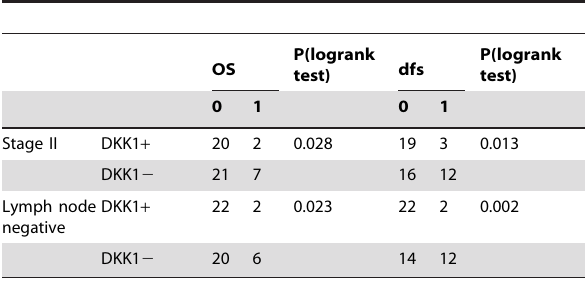
Table 5. Prognostic value of DKK1 in stage II tumor, lymph node negative subgroup.